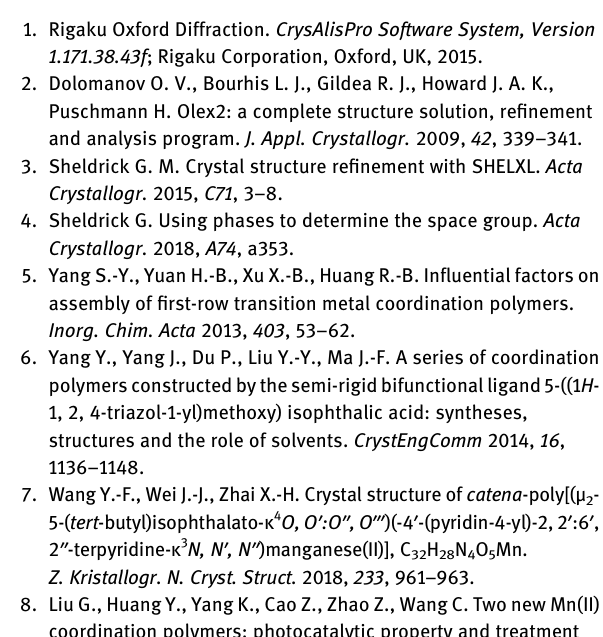
H N O Mn, 11 10 2 7 / c . Its asym- 1